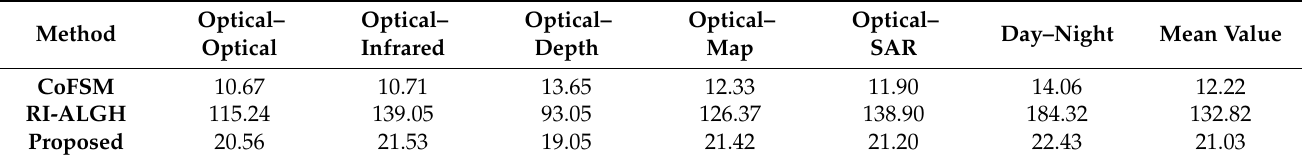
Table 7. RT evaluation results for each